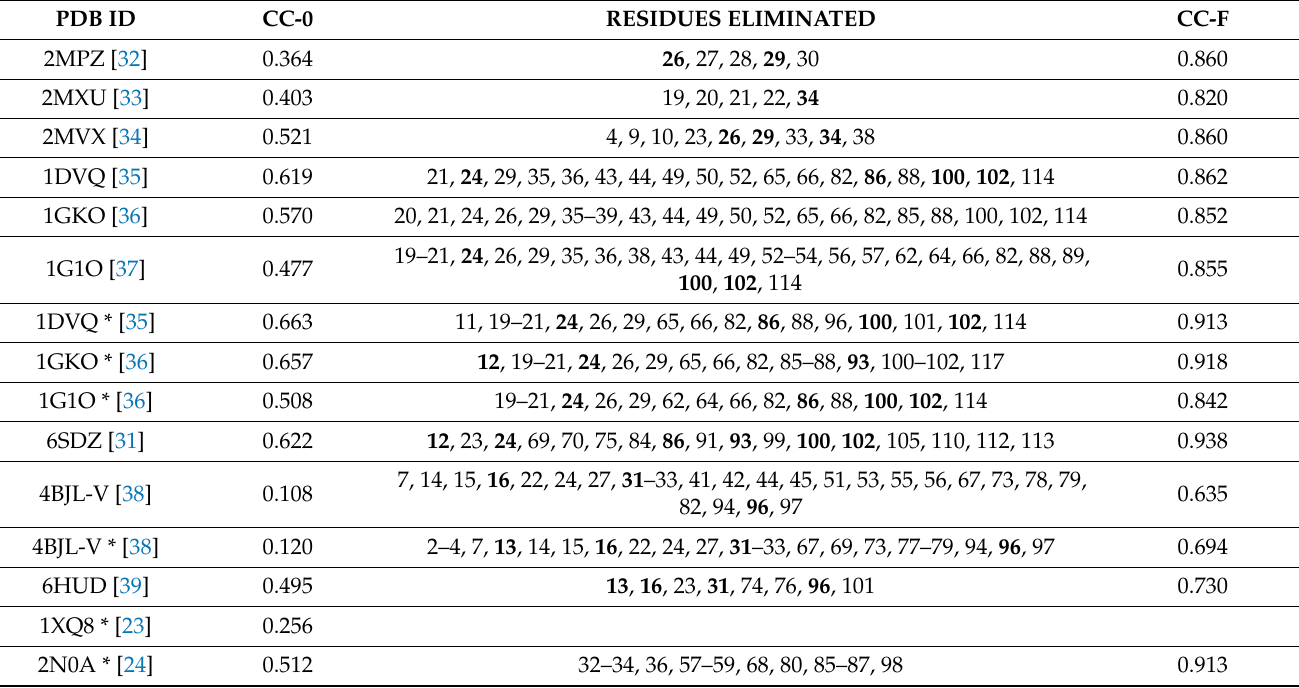
Table 1. Summary of CC-0 and CC-F values for the discussed proteins. Also given are the positions of amino acids considered outstanding and the elimination of which from the CC calculations results in an increase in its